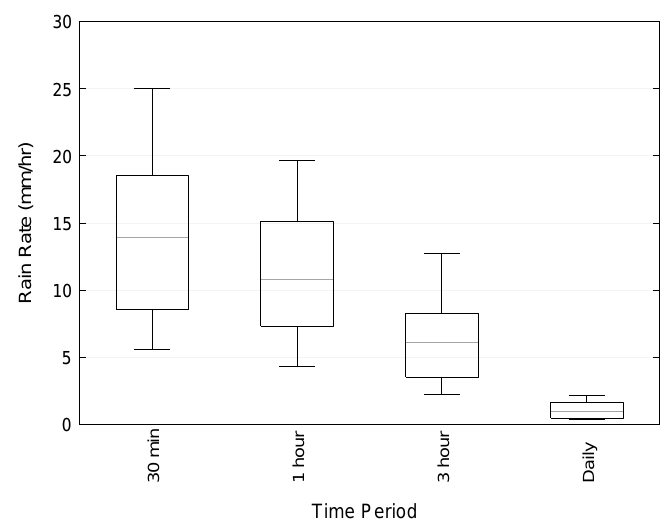
Figure 10. Boxplot for NYC-averaged max rainfall rates over 30 min, 1 h, 3 h, and 1 day for the 86 days of known flooding. Whiskers represent the 10th and 90th percentiles, the box represents the 25th and 75th percentiles, and the line represents the